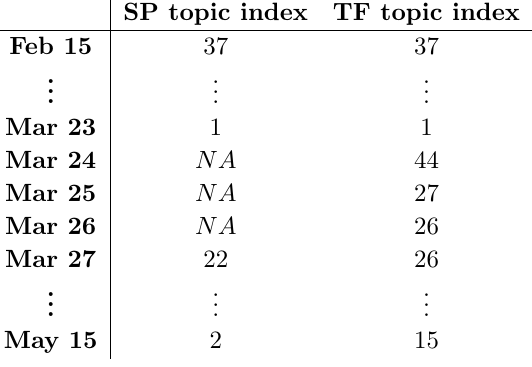
Table F.1. A portion of connected presidential election topics via the shortest path mechanism (left column) and the TopicFlow mechanism (right column).